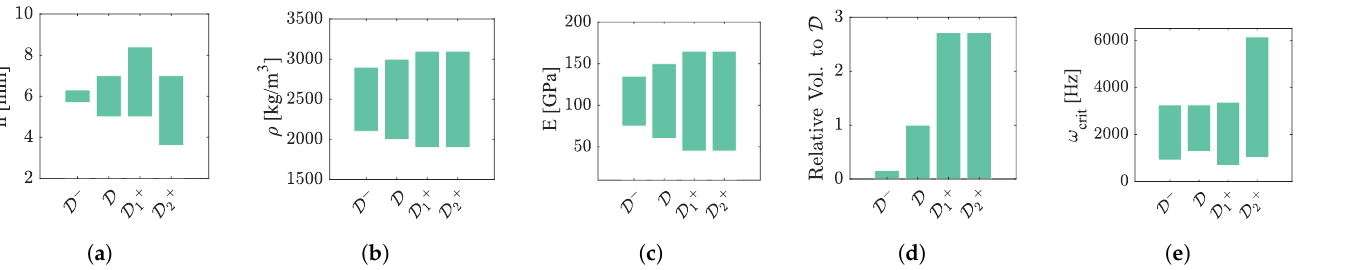
Figure 16. Range of the input variables used for each design space considered ( a – c ), the volume of the design spaces relative to the volume of the standard design space D ( d ) and the range of critical frequencies resulting from each design space ( e ): ( a ) thickness; ( b ) density; ( c ) young modulus; ( d ) design space volume; ( e ) critical frequency.